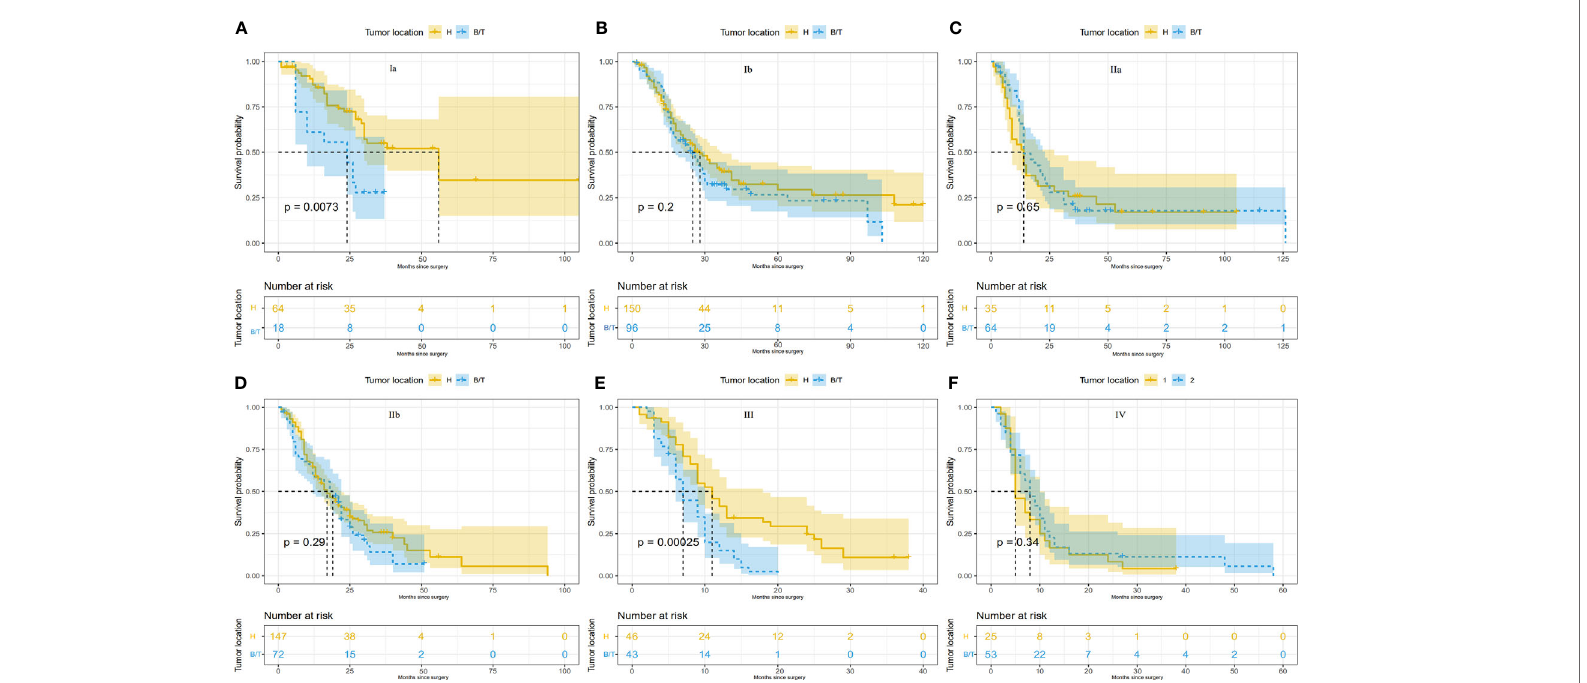
FIGURE 1 | Comparison of survival differences between PHC and PBTC according to the 8 th AJCC system. Comparison between PHC and PBTC in (A) stage Ia; (B) stage Ib; (C) stage IIa; (D) stage IIb; (E) stage III; and (F) stage IV. Signi fi cant differences were observed in Ia and III (p=0.0073 and 0.00025,